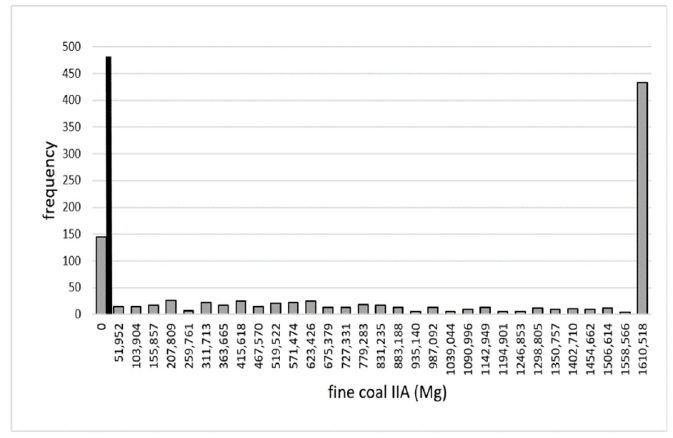
Figure A26. Histogram showing frequencies of achieving given quantity of sales of fine coal IIA (“Dust kettles”) for mine “G” with σ yprog .